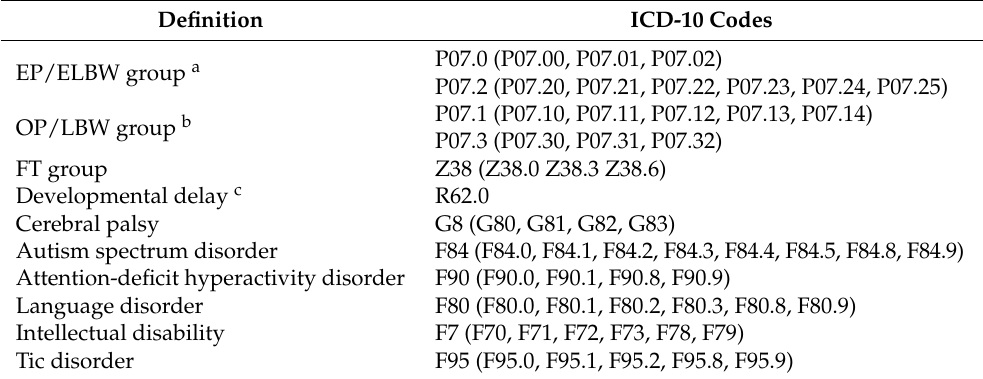
Table 1. ICD-10 diagnostic codes included to the definition of study groups and neurodevelopmen- tal